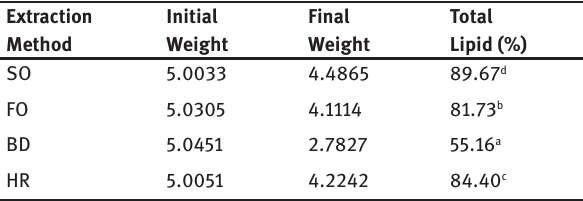
Table 1: Total lipid of beef fat using four extraction methods.